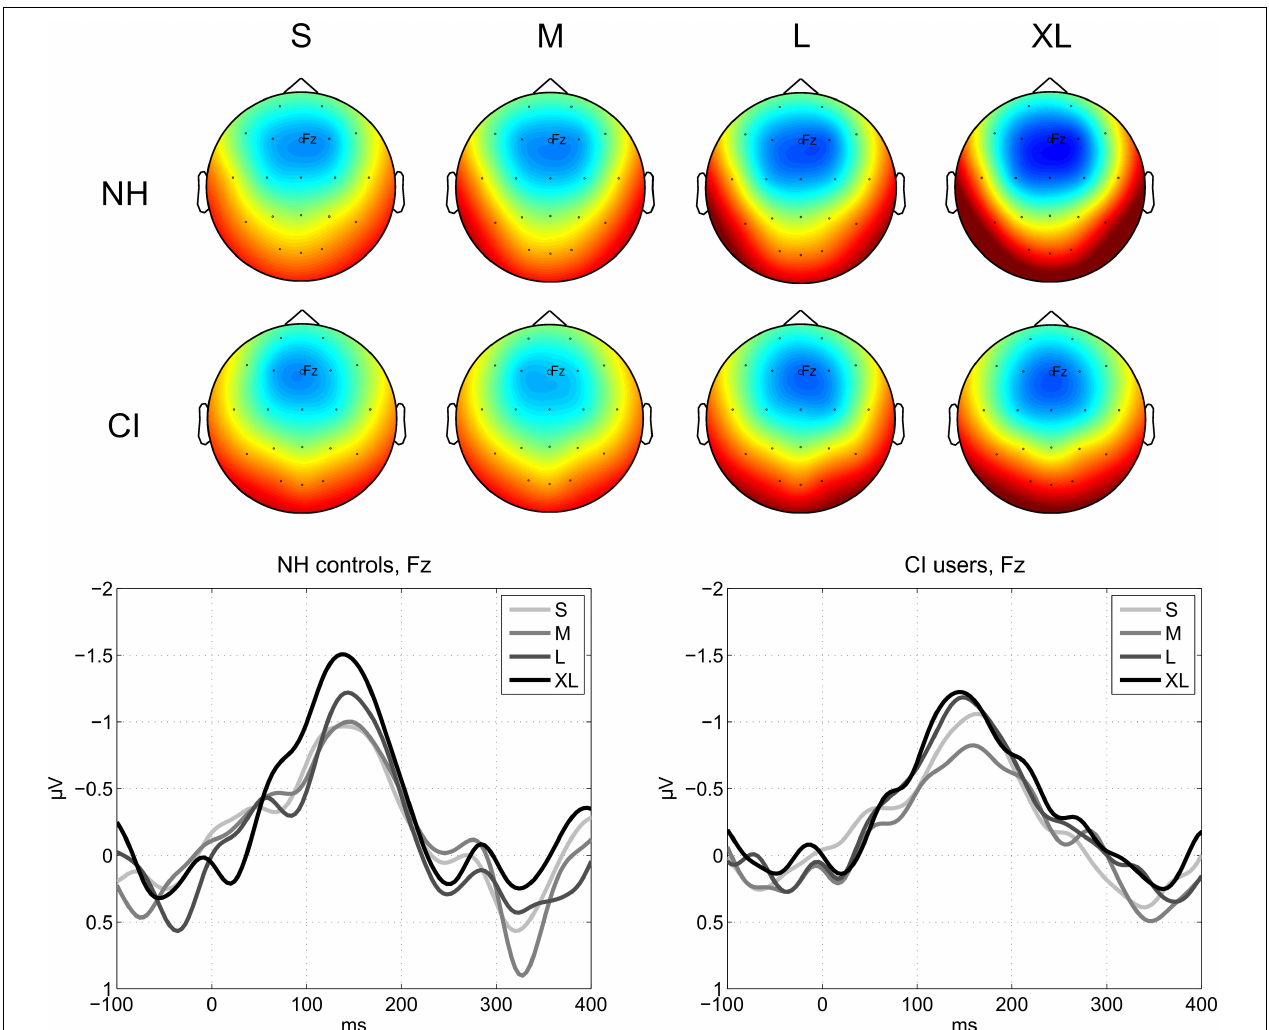
FIGURE 2 | MMN responses to deviant levels. (Top) Average MMN scalp topographies measured in a 30 ms time window centered on the global peak in the grand-average waveform at a latency of 147 ms. The colors are scaled from –2 µ V (blue) to +2 µ V (red). (Bottom) Average MMN waveforms for each deviant level and group measured at the Fz